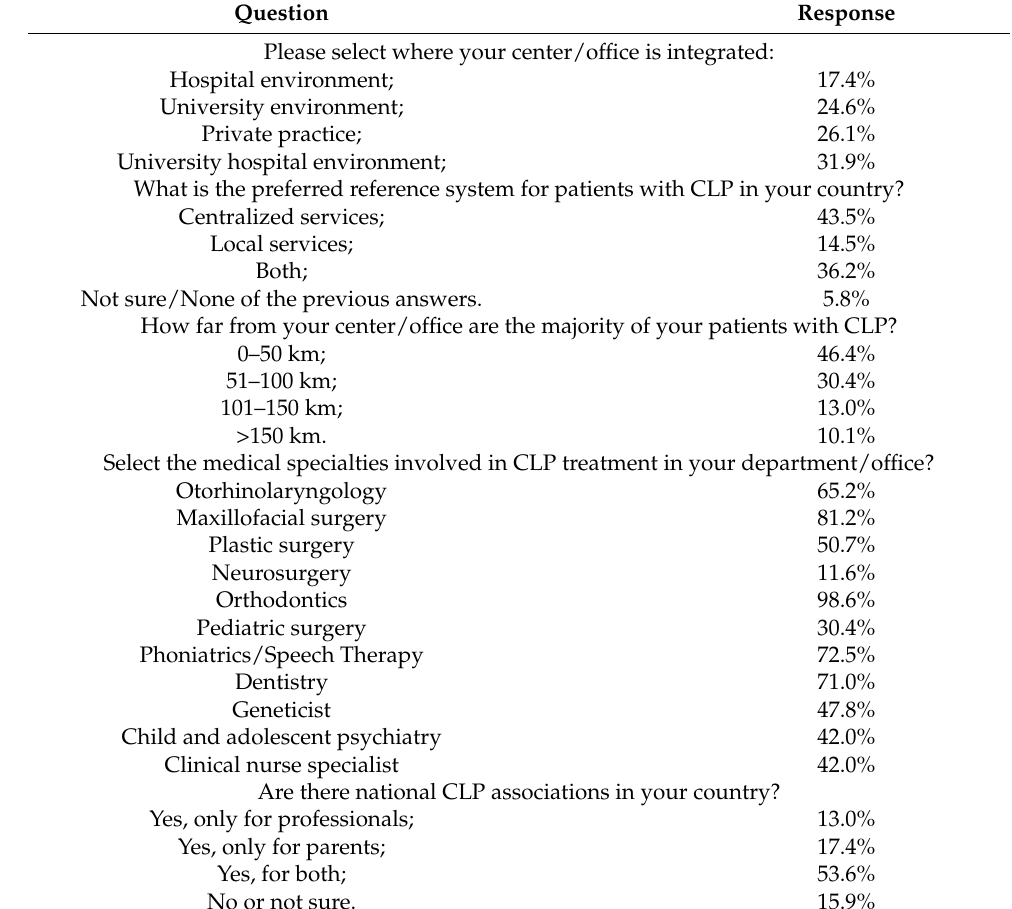
Table 1. Survey results on practice management.